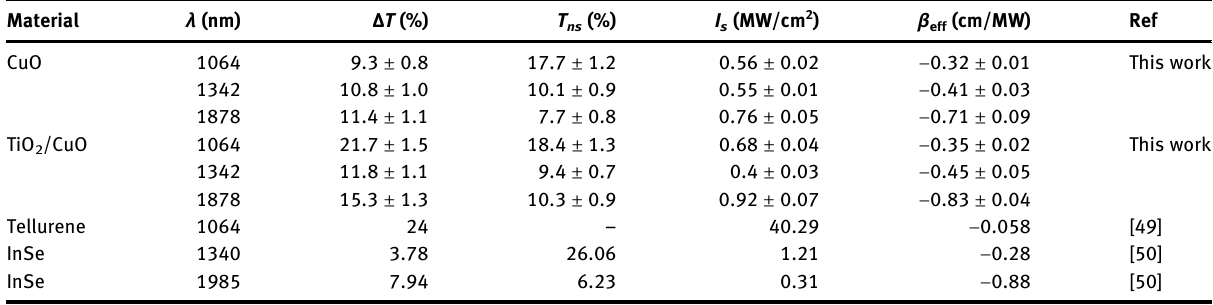
Table  : Nonlinear absorption characteristics of CuO and TiO  /CuO nanocomposites and the comparison with different nanomaterials.